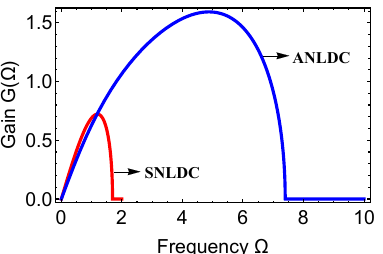
Figure 1. Modulational instability (MI) gain spectra for symmetric nonlinear directional couplers (SNLDC) and asymmetric (ANLDC) couplers in the anomalous group-velocity dispersion (GVD) regime ( σ 1 = 1). Parameters of the symmetric system are P = η = α = Γ = κ = 1 and ρ = χ = 0. For the asymmetric ones, the parameters are the same, except for α = 0.1, Γ = 2, χ = 0.66 and ρ =